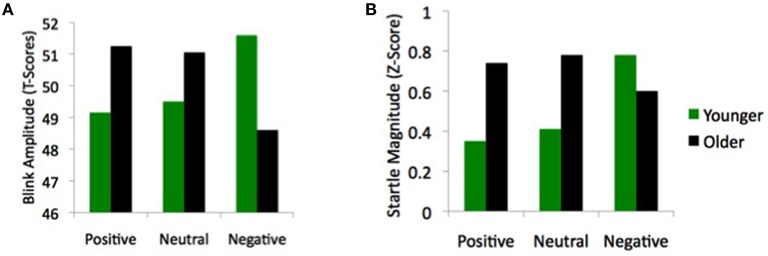
Age-by-valence interactions in startle reactivity from (A) Le Duc et al. (2016); and (B) Feng et al. (2011).